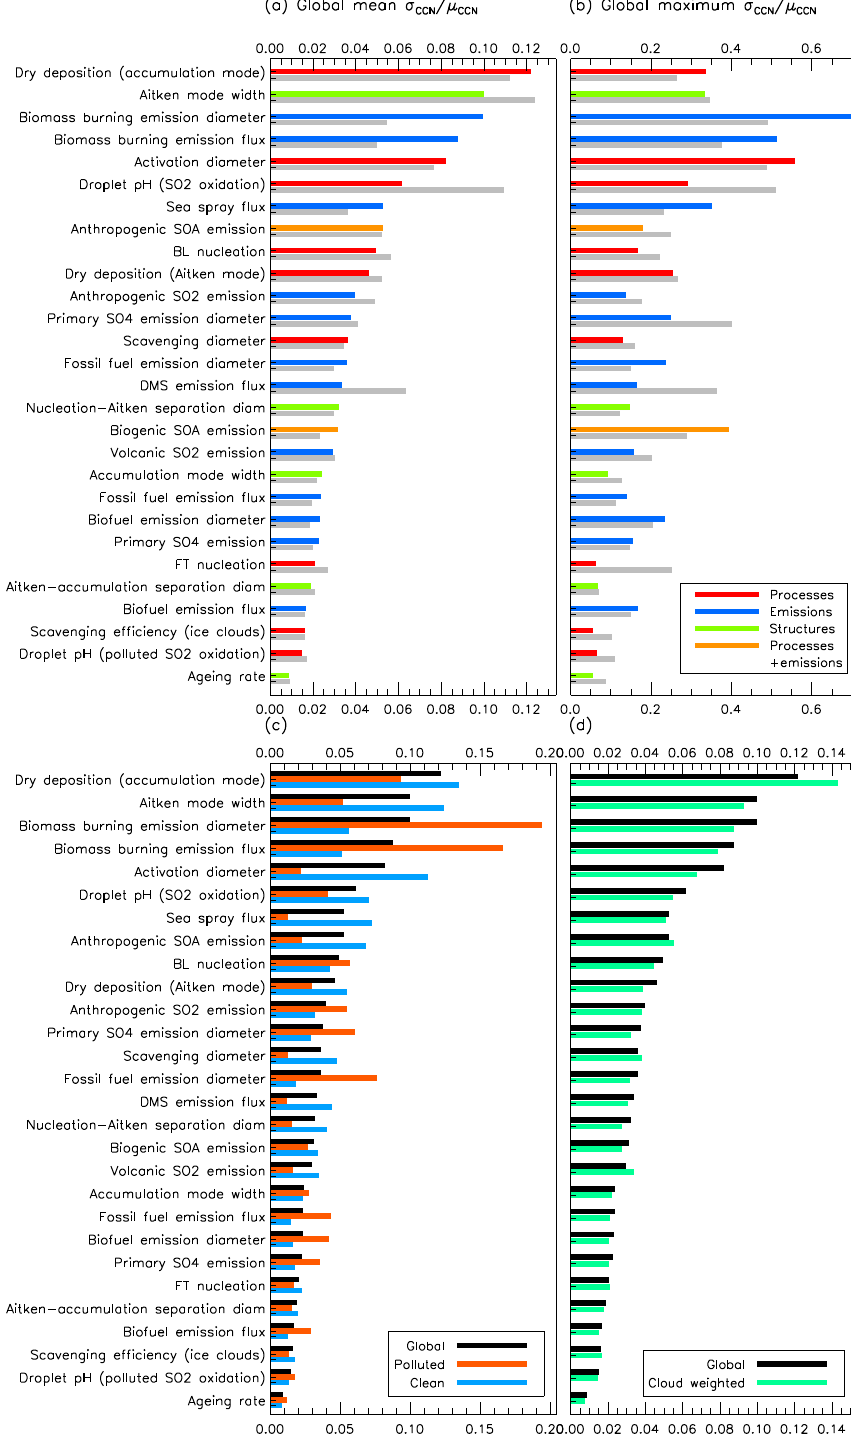
Fig. 8. Global summary of the ranked parameter uncertainties for CCN. (a) Global mean σ CCN ,i /µ CCN , where i is the parameter calculated by globally averaging σ CCN ,i /µ CCN over all grid boxes, weighting by grid-box area. The ranked uncertainties are shown in colour for July and in grey for January. The colours show the classification of the parameters according to model processes (red), emissions (blue), processes and emissions (orange) and the model structure (green). (b) Global maximum σ CCN ,i /µ CCN calculated over a coarser grid (32 × 16 grid boxes) than the GLOMAP grid (128 × 64 grid boxes) in order to suppress noise in the data. (c) Stratified into polluted and clean mean σ CCN ,i /µ CCN for July. Polluted is defined as BC > 100ngm − 3 and clean as BC < 50ngm − 3 . The black bars are July global means from (a) . (d) Global rankings for July are weighted by ISCCP global low level cloud volume